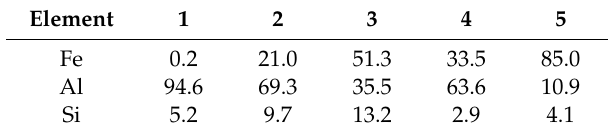
Figure 3. Backscattered electron images and the corresponding elemental distributions in Al-Si coated specimens, as-received state ( a ) and after hot-stamped at 1193 K ( b ). The average chemistry in location 1 of Figure 3a indicated the existence of α (Al) matrix and eutectic Al-Si phase. The average chemistry in location 2 of Figure 3a indicated that the dominant phase in Layer II was Fe 2 Al 7 Si ( τ 5 ) ternary intermetallic compound. The average chemistries in locations 3, 4 and 5 in Figure 3b indicated formation of Fe(Al,Si) ( β 2 ), Fe(Al,Si) 2 and α (Fe) phases, respectively. Table 2. The average chemical compositions of different phases at locations 1–5 as marked in Figure 3